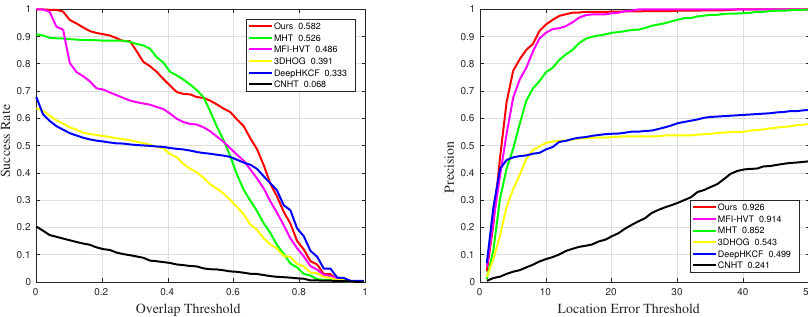
Figure 19. Quantitative results for sequences with challenge OCC.